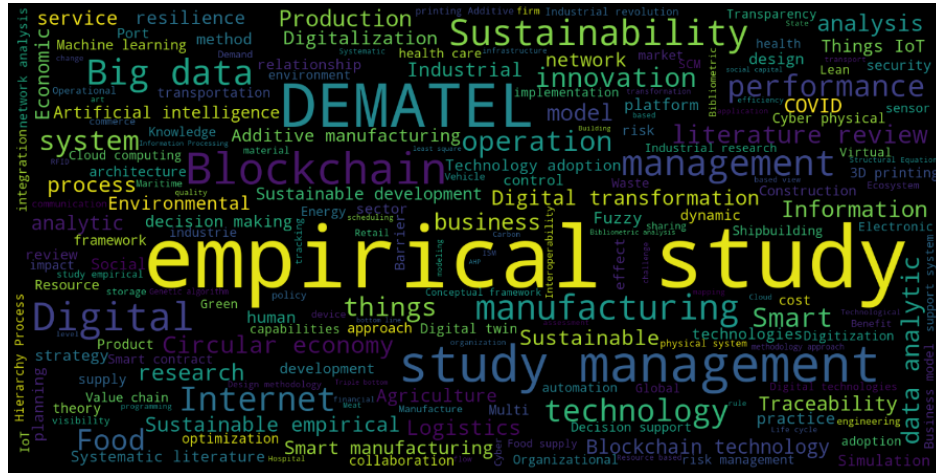
Figure 6. Word Cloud on “Abstracts”.